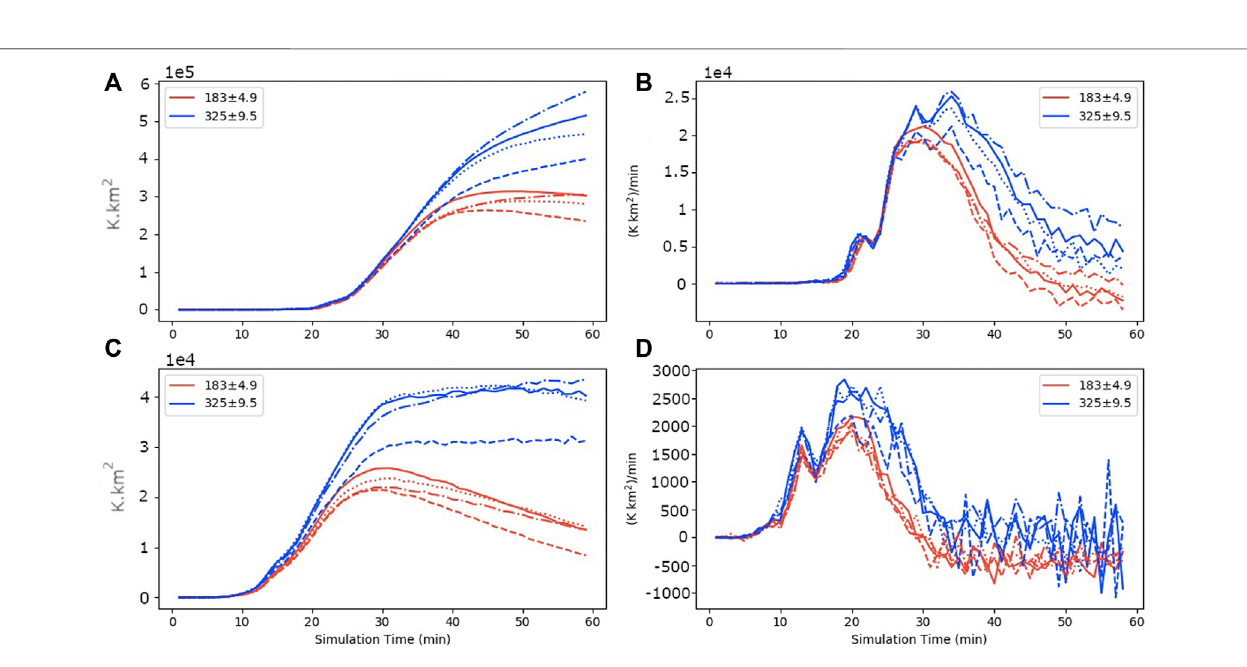
FIGURE 4 | Time series of Integrated Scattering Depression (ISD, in K.km 2 , subplots (A,C) and its time derivative dISD/dt (in K.km 2 /min, subplots (B,D) for the C4 (183 ± 4.9GH,in red) and theC9 (325 ±9.5 GHz, in blue)SAPHIR-NG channels. Top row: strong convection; bottom row: weakconvection. The linestyles indicate the microphysics perturbation experiments (see Figure 2